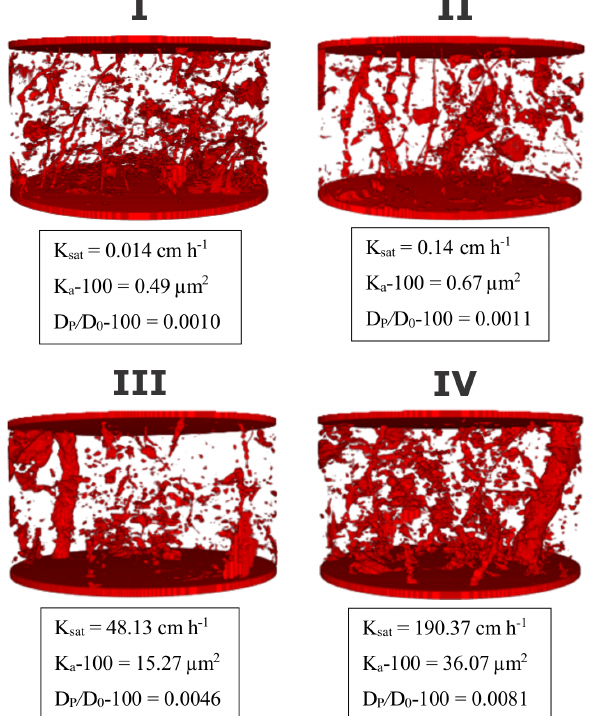
Figure 3. Three-dimensional visualizations of sample soil columns and associated measured macropore flow parameters. K sat is sat- urated hydraulic conductivity, and K a − 100 and D P /D 0 − 100 are air permeability and gas diffusivity at − 100cm matric potential, re- spectively.